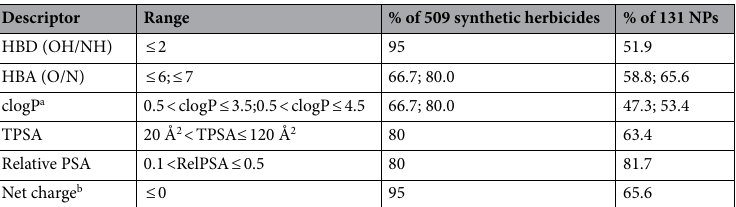
Table 4. Herbicide-like chemical space defined in terms of common molecular descriptors (Fig. 5). a Regardless logP values were calculated by ADMET Predictor or DataWarrior. b More than 95% of synthetic organic herbicides are either neutral molecules (around 2/3) or anions (30%) (Figure